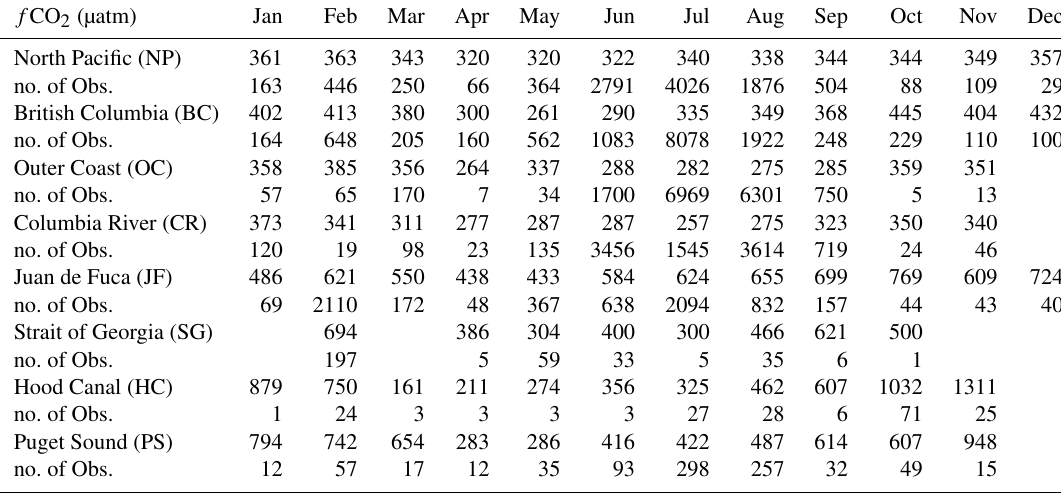
Table B5. Average monthly f CO 2 seasonal cycles for the eight unique regions. The total number of observations (no. of Obs.) contributing to the monthly average estimate is included.